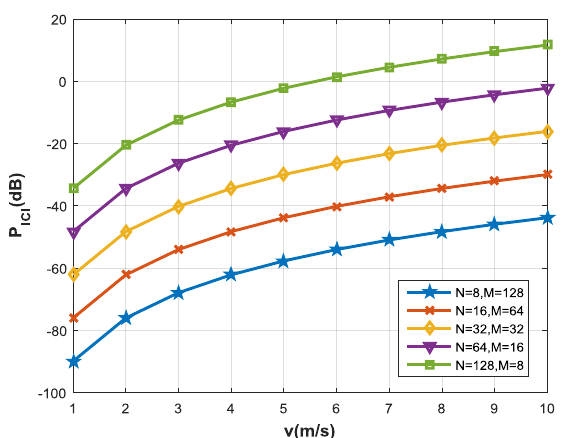
Figure 10. The relationship between P ICI and relative velocity of transmitter and receiver.